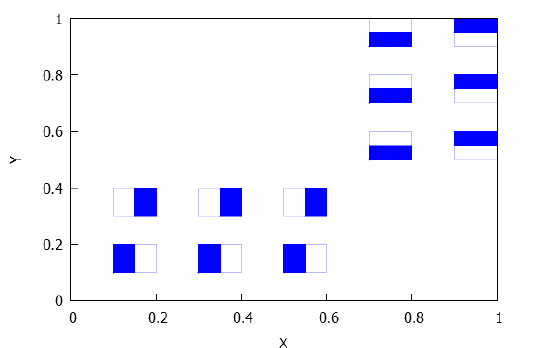
Figure 12. A mixing and B no mixing. Distribution D5. Here, p = 2, q = 3, (cid:96) = 6; each ‘entire’ rectangle R in L 1 verifies p 1 ( π 1 ( R )) = 3 = (cid:96) R (cid:48) in L 2 holds p 2 ( π 2 ( R (cid:48) )) = 3 = (cid:96)